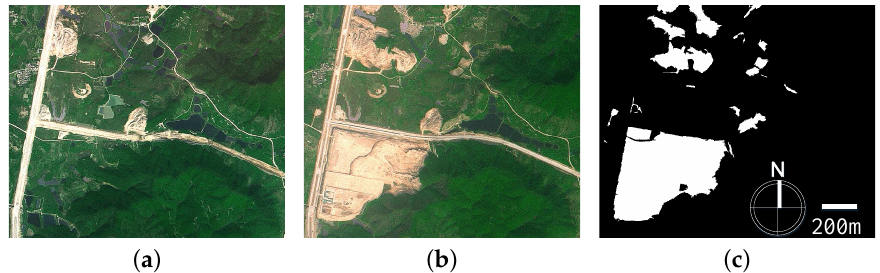
Figure A4. The Guangzhou dataset: ( a ) the multispectral image acquired in October 2006, ( b ) the multispectral image acquired in October 2007, and ( c ) the reference image.